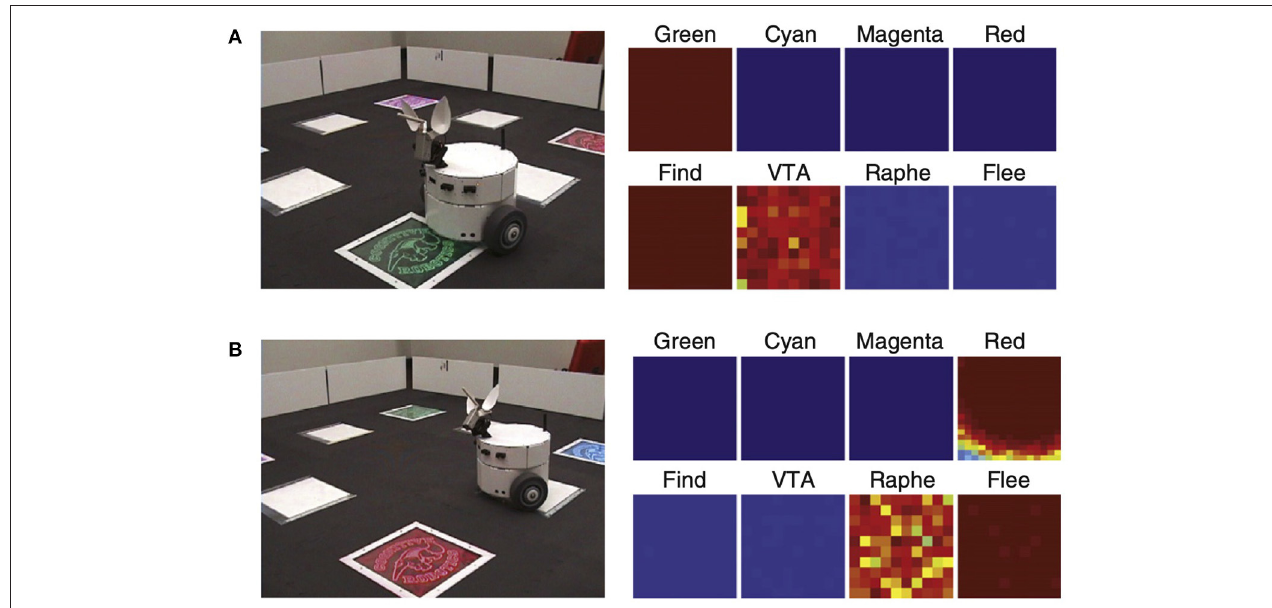
FIGURE 6 | CARL robot in colored panel task. The panels could flash any of six different colors. One color, green, signaled positive value. Another color, red, signaled negative value. The remaining colors were neutral. Positive and negative signals were transmitted from the panel to a receiver on the bottom of CARL. (A) CARL during an approach or find response. The panels on the right show strong neuronal activity in its simulated green visual area, the dopaminergic system (VTA), and the find motor neurons. (B) CARL during a withdrawal or flee response. The panels on the right show strong neuronal activity in its simulated red visual area, the serotonergic system (raphe), and the flee motor neurons. Adapted from Cox and Krichmar